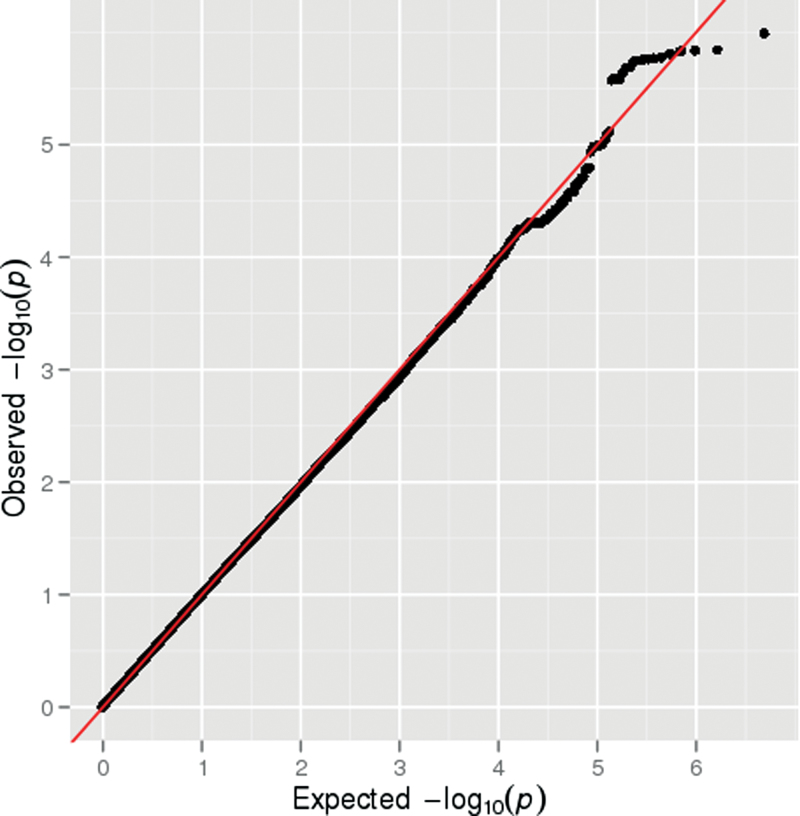
Q-Q plot for the genome-wide association studies of definite psychotic experiences at ages 12 or 18.